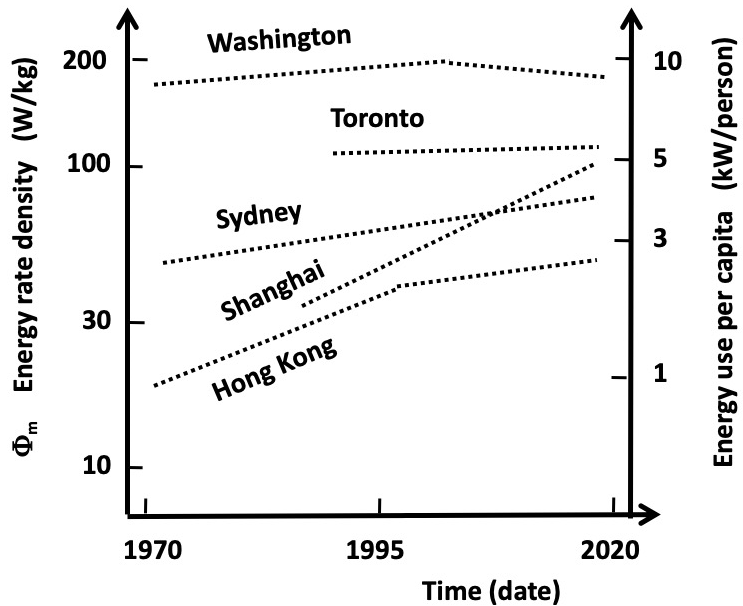
Figure 3. This graph shows energy usage rising (for adolescent cities) and then flattening (for mature cities) with Φ m values plotted at left and equivalent per-capita energy use at right for a sampling of major cities around the world during the past half-century.